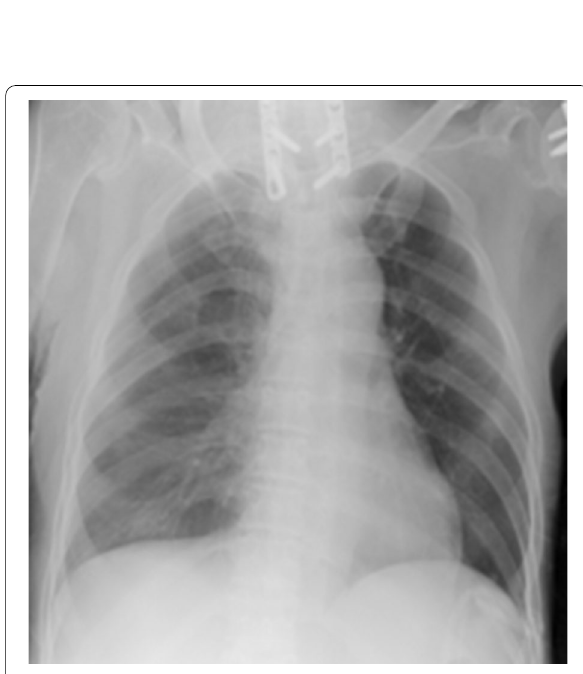
Fig. 3 The hydrothorax was resolved after the operation despite the re-initiation of peritoneal